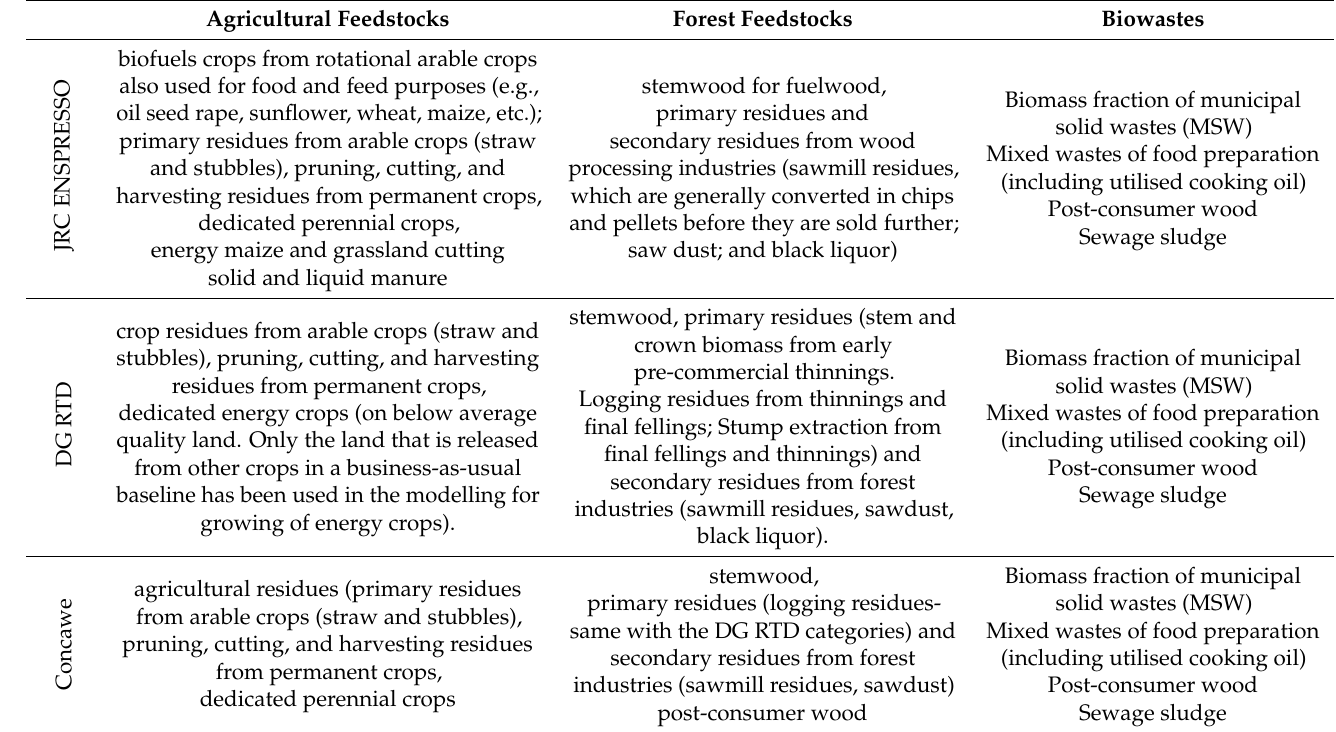
Table 4. Feedstock categories included in the biomass assessment